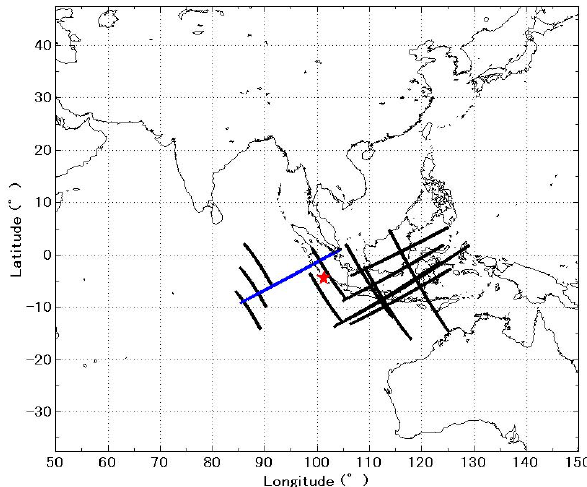
Fig. 14. Locations of points at which profiles were computed from FORMOSAT-3/C occultation data during 06:00–09:00 on 25 Au- gust 2007 and 9 September 2007. The red star indicates the epi- center. The blue line and the black lines represent the trajectories on 9 September 2007 and for the reference data (15-day backward median).